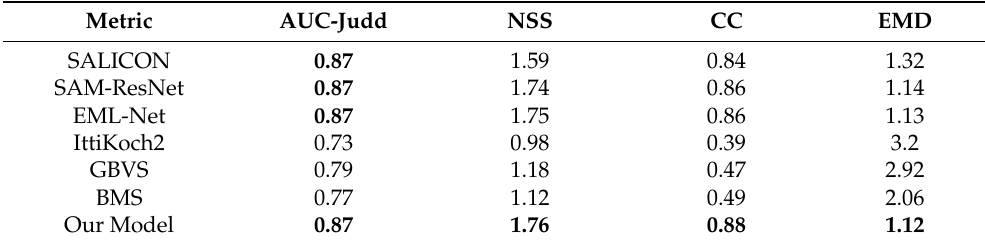
Table 2. Quantitative results of evaluation measures on the Emod validation dataset.